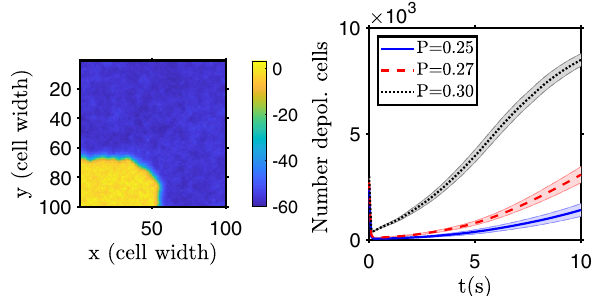
Figure 2. Tissue depolarization for randomly distributed depolarized cells on a polarized domain. Left: example of the two-dimensional domain polarization state after 10 seconds (yellow corresponds to depolarized cells and blue to polarized ones; the color bar shows the membrane electrical potential in mV). Figure S3 shows the spatial distribution of the depolarized cells at different time points, and Supplementary Movie 3 shows an animation of the system evolution in space and time. Right: evolution of the number of depolarized cells for different percentages of depolarized cells randomly initially distributed on the domain (25%, 27% and 30% of the total number of cells depolarized). The initial decrease on the number of depolarized cells (see Fig. S2 for the same plot in semi-logarithmic scale for a more detailed display of the first time steps) is due to a community effect, where depolarized cells with a high number of polarized neighbors will polarize fast. The bands show the standard deviation of the mean of n = 20 simulation